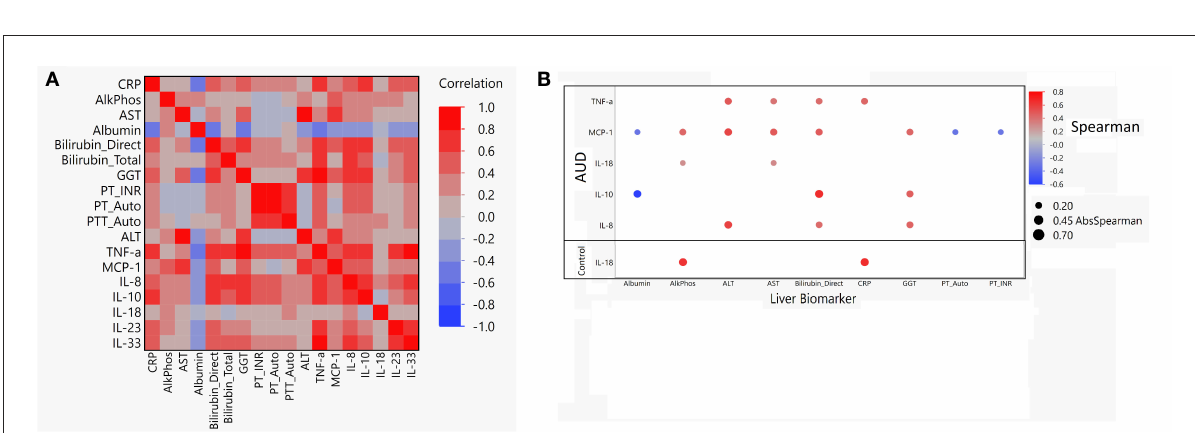
FIGURE6 Spearman correlation matrix and dot plot of cytokines compared to liver function biomarkers. (A) Spearman correlation heat map of cytokines vs. liver biomarkers in AUD. Red indicates a Spearman correlation of 1 and blue indicates a Spearman correlation of − 1. (B) Dot map of significant correlation of cytokine compared to liver biomarker for both AUD and controls. Blue dot indicates negative correlation and red dot indicates positive correlation. Size of the dot indicates absolute value of the magnitude of the correlation. If dot is present, P < 0.05 was reached.